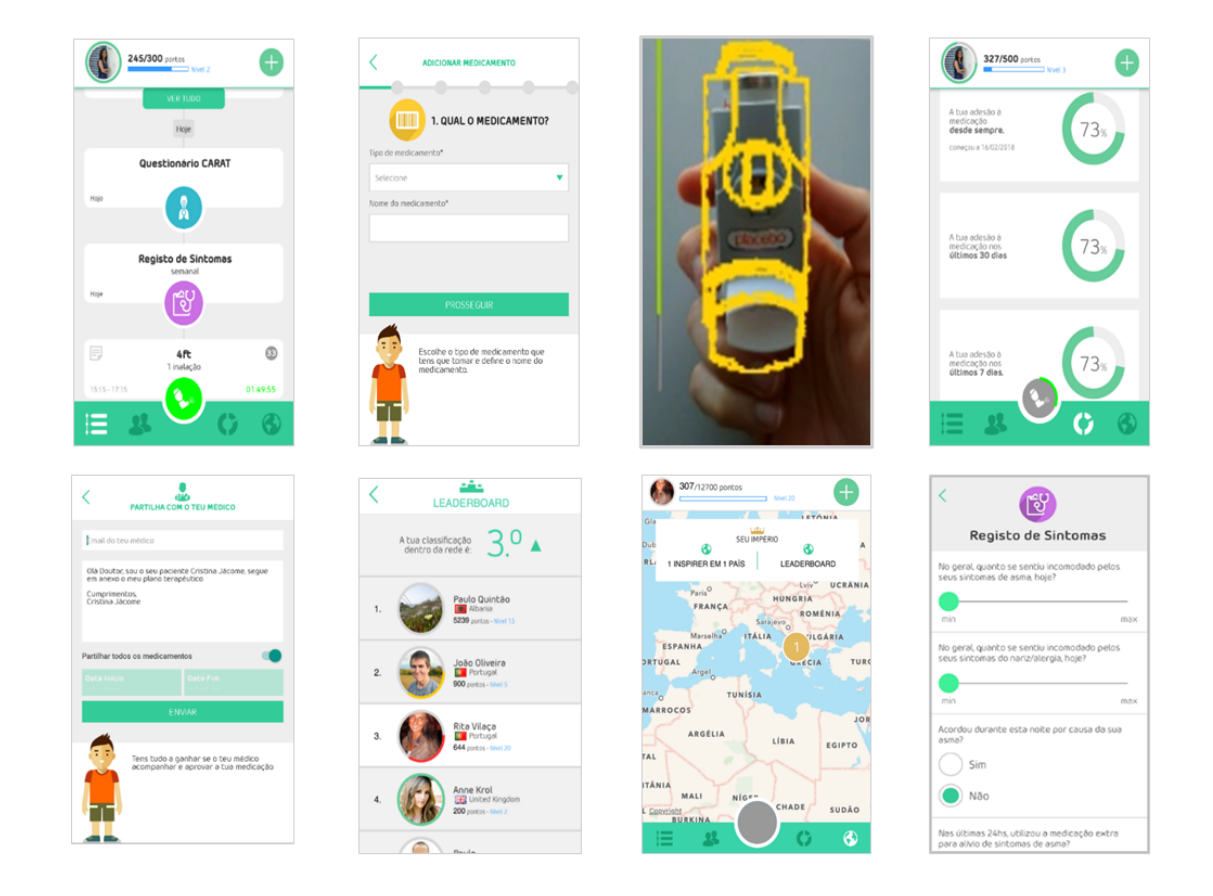
Figure 1. InspirerMundi app screenshots (version